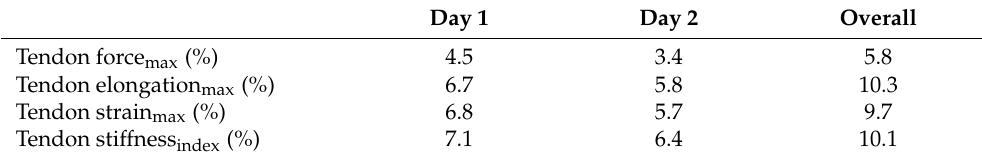
Table 2. Coefficient of variation within day one, day two, and overall, for the analyzed parameters describing the mechanical properties of the Achilles